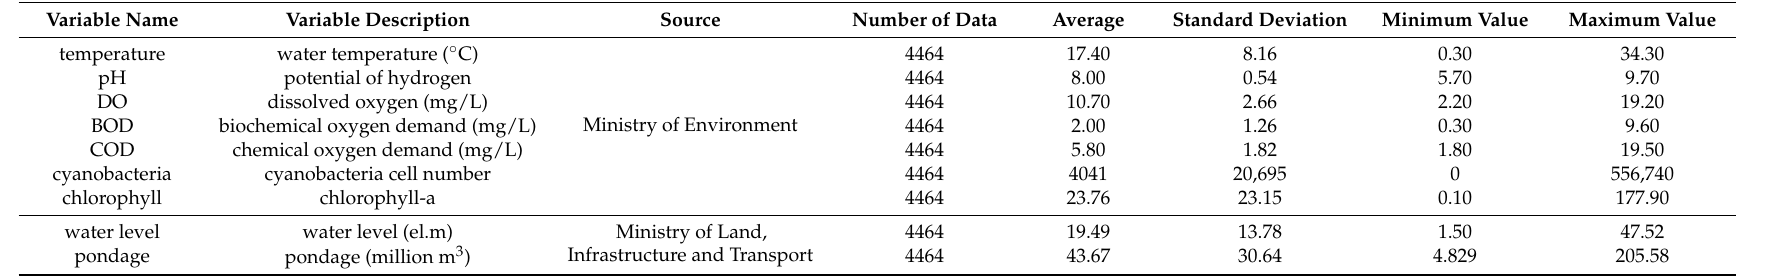
Table 1. Variables used in model tests and their basic statistical